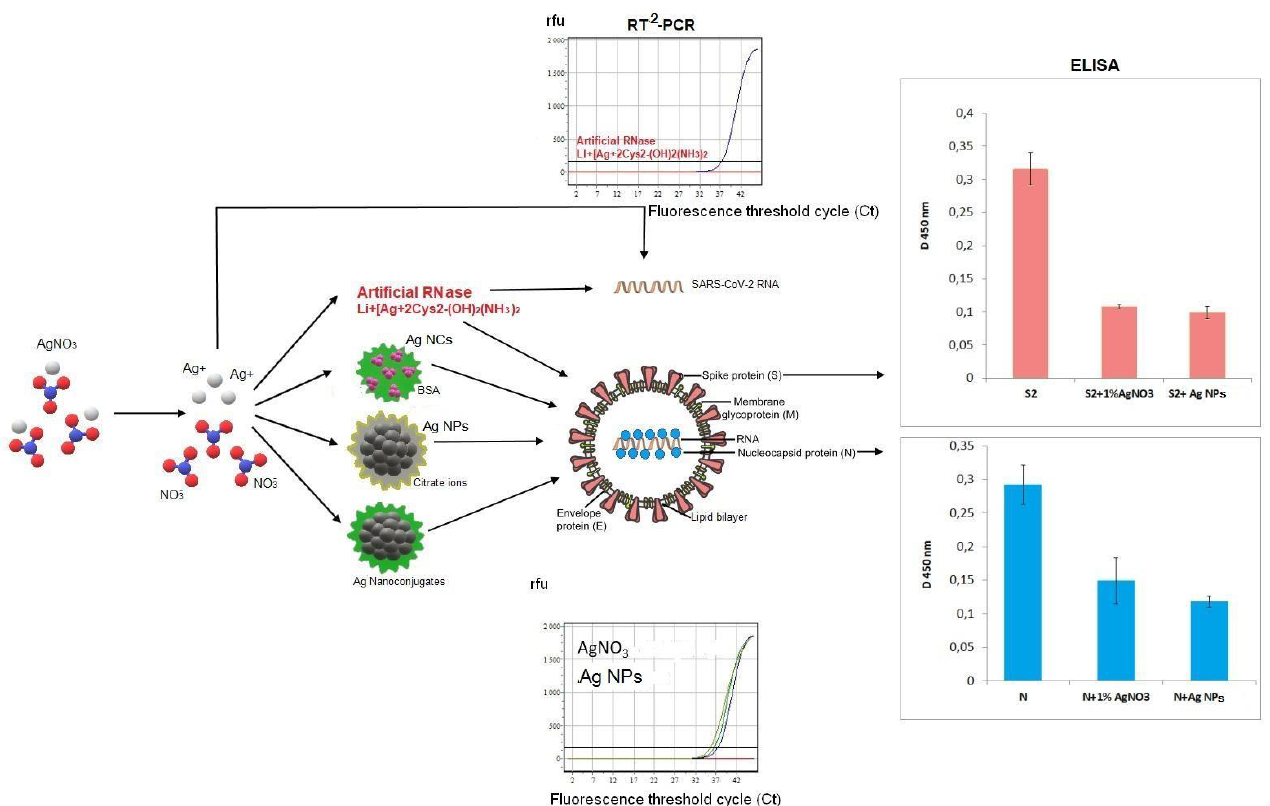
Figure 3. Scheme of SARS-CoV-2 molecular targets and part of available data of RT 2 -PCR and ELISA. SARS-CoV-2 spike surface protein S is shown in pink in both central virion scheme and in the corresponding ELISA data (the histogram in the upper right corner); the coronavirus nucleocapside protein N is shown in blue colour in the central scheme and in the corresponding ELISA data (the histogram in the lower right corner). RT 2 -PCR data demonstrate the fluorescent curves of dependence between PCR cycles (axis X with threshold cycle (Ct)) and the fluorescence emission in relative fluorescence units (r.f.u.).